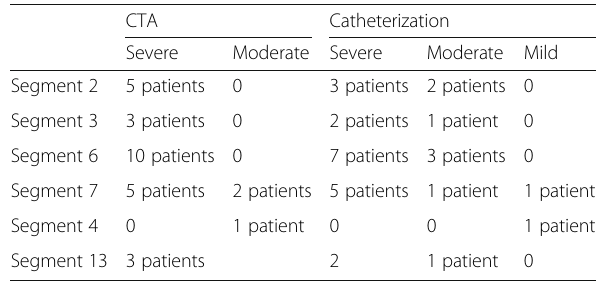
Table 4 Detailed positive result of CTA as regard to